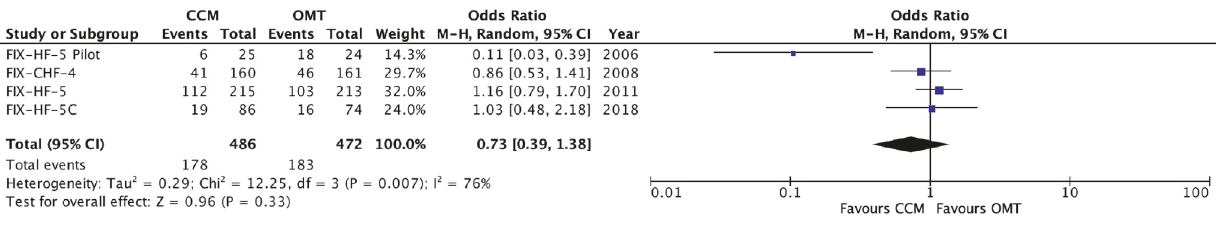
Figure 3: Forest plot of total hospitalizations in the CCM groups versus the control groups. A forest plot of the data available to us from the 4 RCTs assessing total hospitalizations in those with CCM compared to those with OMT alone. There was a nonsignificant difference in the rate of total hospitalizations between the two groups.